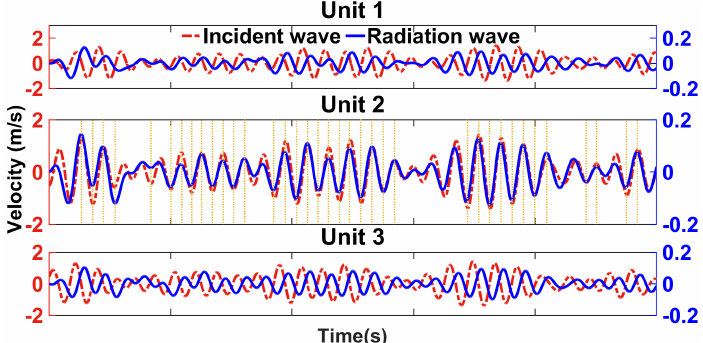
Figure 8. Wave velocity of the interacting radiation wave and the incident